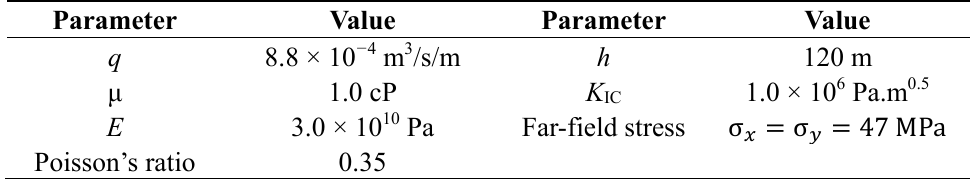
Figure 7. Comparison of propagation paths for initiation fractures in ( a ) a horizontal wellbore and ( b ) two horizontal wellbores. The line width represents the fracture aperture. Table 3. Input parameters (Reproduced from Wu and Olson